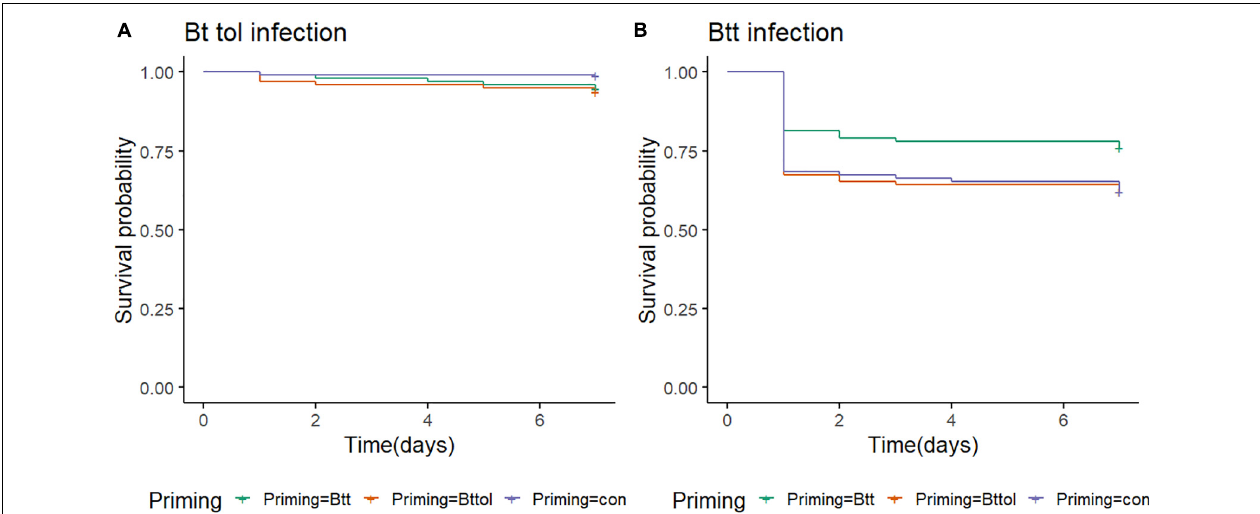
FIGURE 6 | T. castaneum survival upon different priming treatments. (A) There is no increase in survival of 19-day-old beetle larvae orally infected with Bt tolworthi spores (5 × 10 9 mL − 1 ) when previously primed with Btt or Bt tolworthi supernatants [Cox proportional hazards (coxph): X 2 = 4.74, Df = 1.96, p = 0.09]. (B) Survival of 19-day-old beetle larvae orally infected with Btt spores (5 × 10 9 mL − 1 ) is increased when previously primed with Btt supernatant [Cox proportional hazards (coxph): X 2 = 5.9, Df = 2, p = 0.05]. 5 days prior to the spore infections, larvae were exposed to priming diet mixture with flour and either sterile supernatants of Btt , Bt tolworthi or control Bt